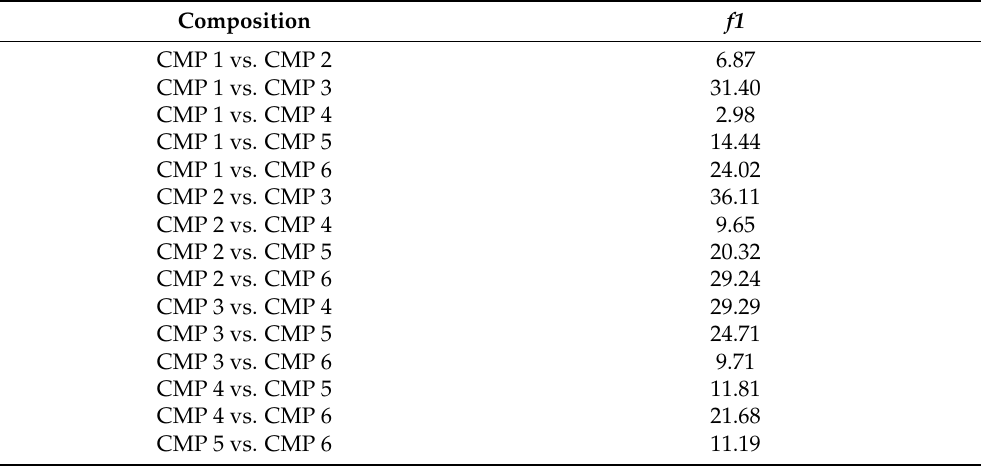
Table 9. Difference factors to compare the different release profiles of the ointments.